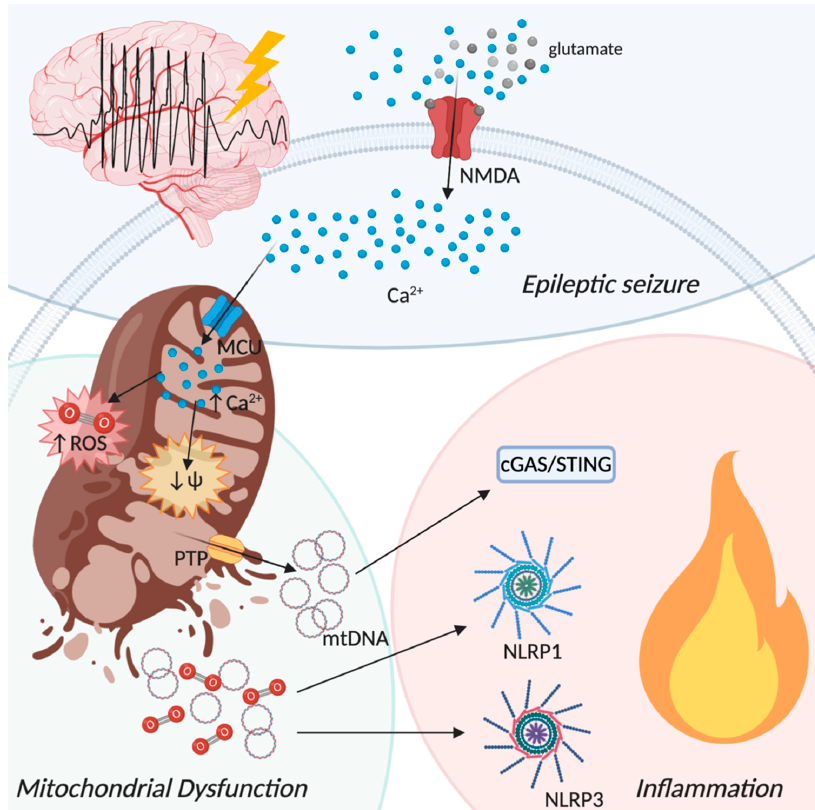
Figure 4. Epileptic seizure from a mitochondrial perspective. Repeated epileptic seizures activate NMDA receptors with the consequent influx of Ca 2+ into the cytoplasm. Additionally, in this scenario, increased cytoplasmic Ca 2+ concentration activates MCU. Augmented mitochondrial Ca 2+ level triggers the activation of different enzymes responsible for reactive oxygen species production (ROS), such as nitric-oxide synthase and NADPH oxidase, and leads to membrane depolarization with the opening of the permeability transition pore (PTP) and mitochondrial membrane disruption. Release of mitochondrial components in the cytoplasm activates proinflammatory pathways such as NLRP1 and NLRP3 inflammasome assembly and the cGAS-STING dsDNA sensing machinery, leading to progressive inflammation. Created with BioRender.com.